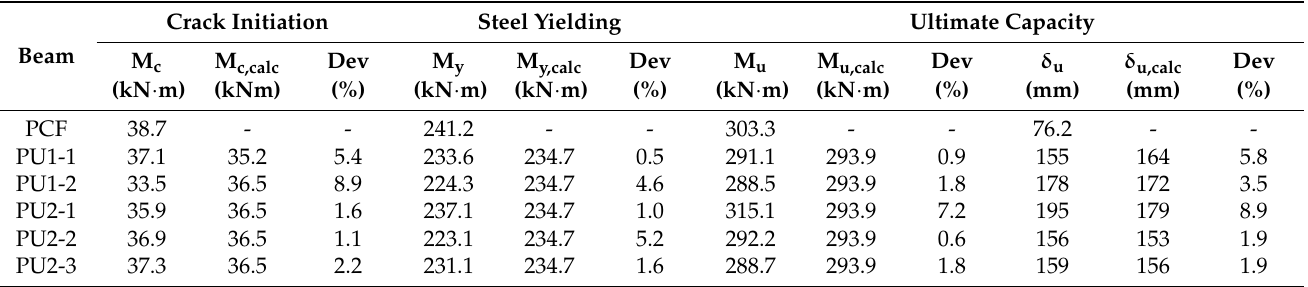
Figure 18. Stress variation along CFRP bar for the different adhesives. Table 7. Moment and deflection predictions and test